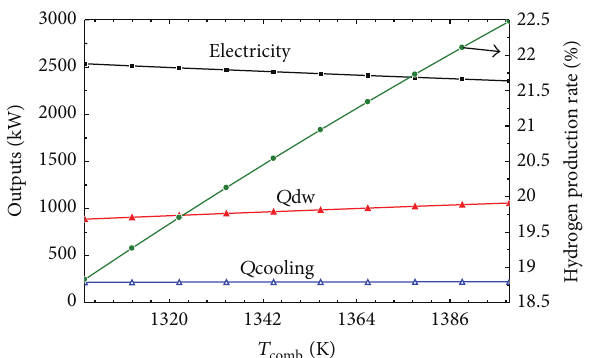
Figure 9: The impact of the inlet temperature to chiller on the objective